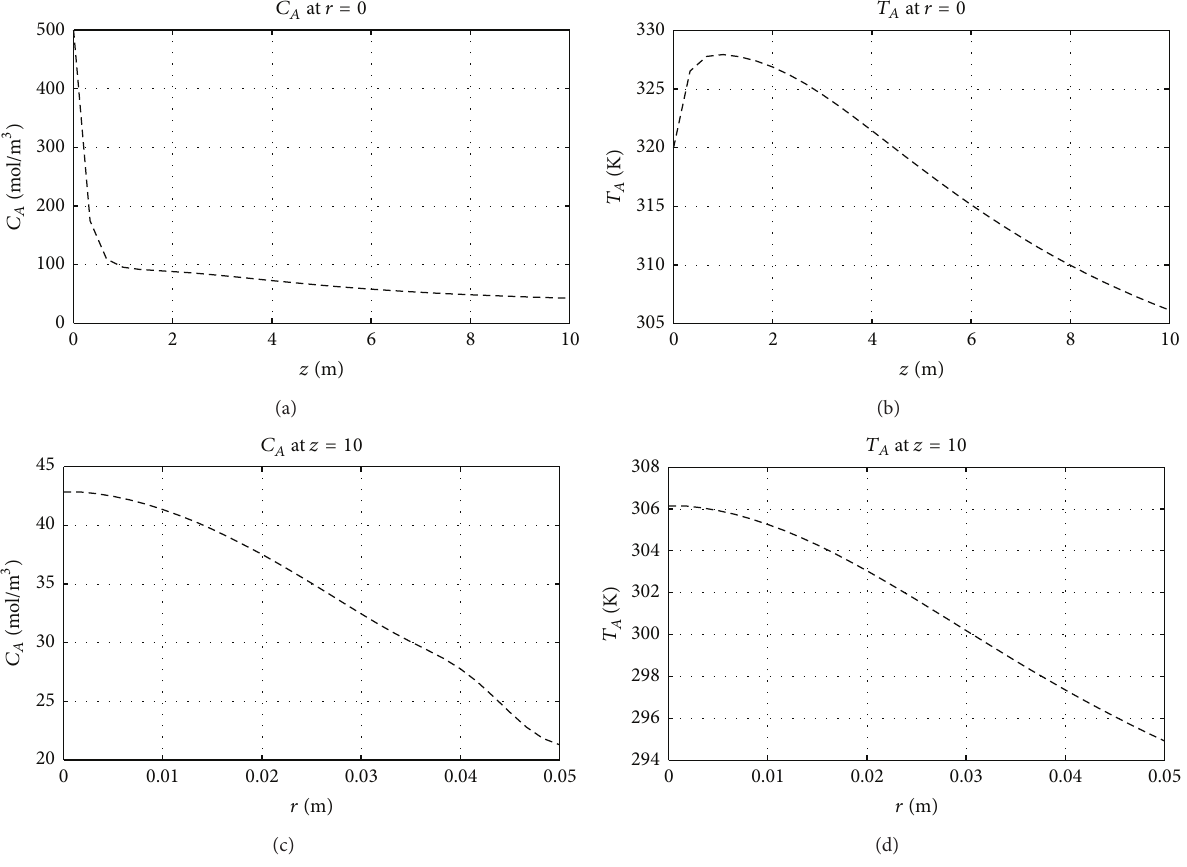
Figure 5: Steady state concentration and temperature profiles at 𝑟 = 0 m and 𝑧 = 10